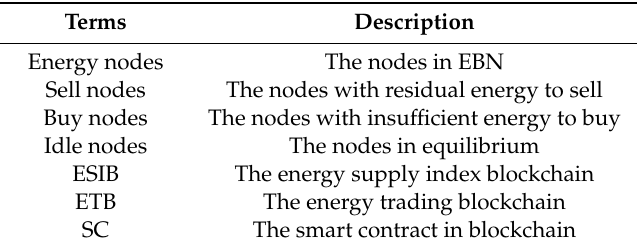
Table 1. Main relevant terms in energy blockchain network (EBN). Terms Description Energy nodes The nodes in EBN Sell nodes The nodes with insu ffi cient energy to buy The nodes in equilibrium ESIB The energy supply index blockchain ETB The energy trading blockchain SC The smart contract in blockchain